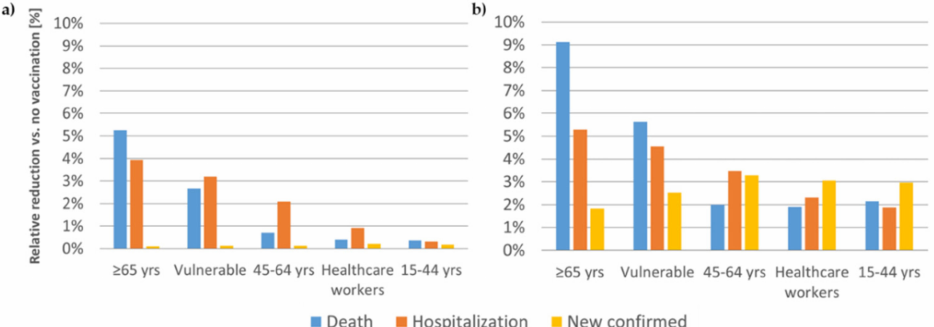
Figure 1. ( a ) Non-sterilizing vaccine: total impact of vaccinating the first 200,000 individuals in different target populations with a non-sterilizing vaccine on deaths, hospitalizations, and new confirmed infections. ( b ) Sterilizing vaccine: total impact of vaccinating the first 200,000 individuals in different target populations with a sterilizing vaccine on deaths, hospitalizations, and new confirmed infections. yrs—years; vulnerable: individuals with increased risk of severe COVID-19 disease once infected. Analysis assumed a vaccine effectiveness of 70% in the general population and of 60% in the age group